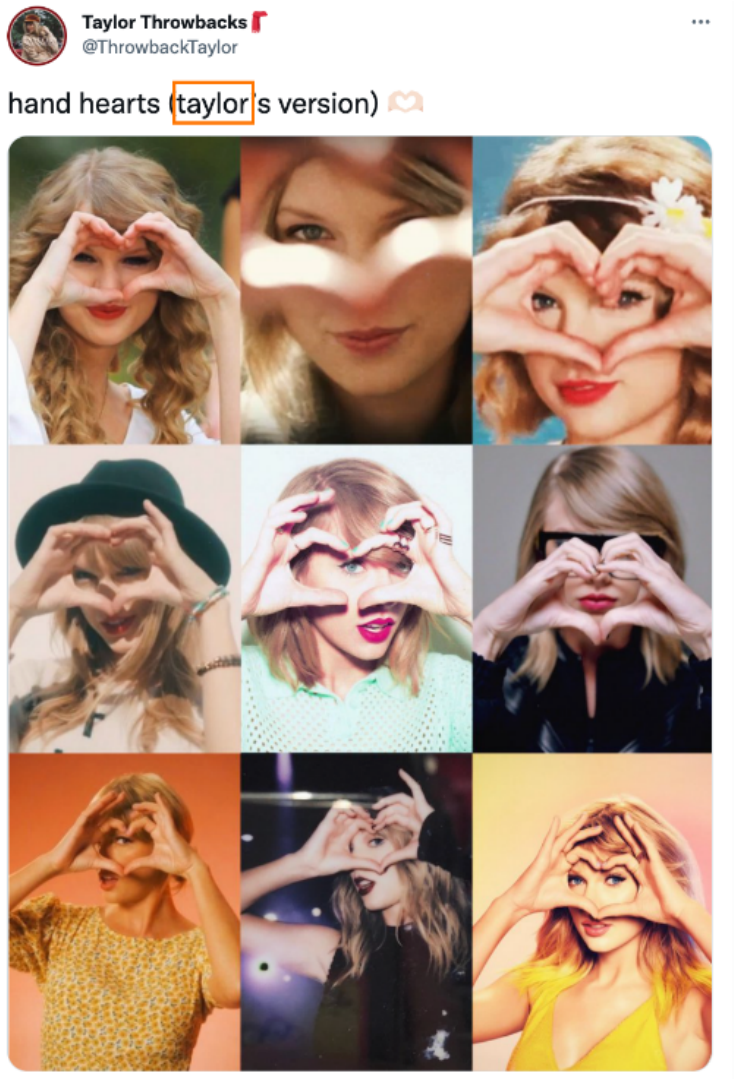
Figure 1. An example of tweets where taylor in the text is an ambiguous